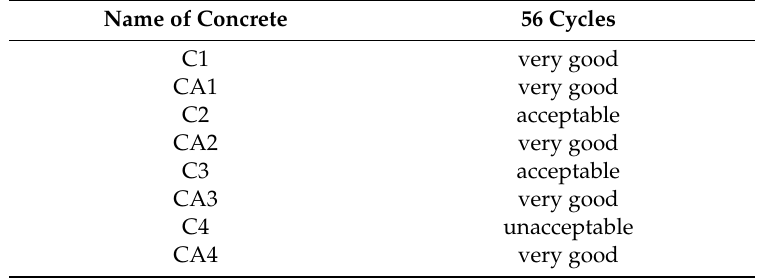
Table 7. The quality of concretes after 56 cycles of scaling with de-icing salt according to SS 137244 [6]. Name of Concrete